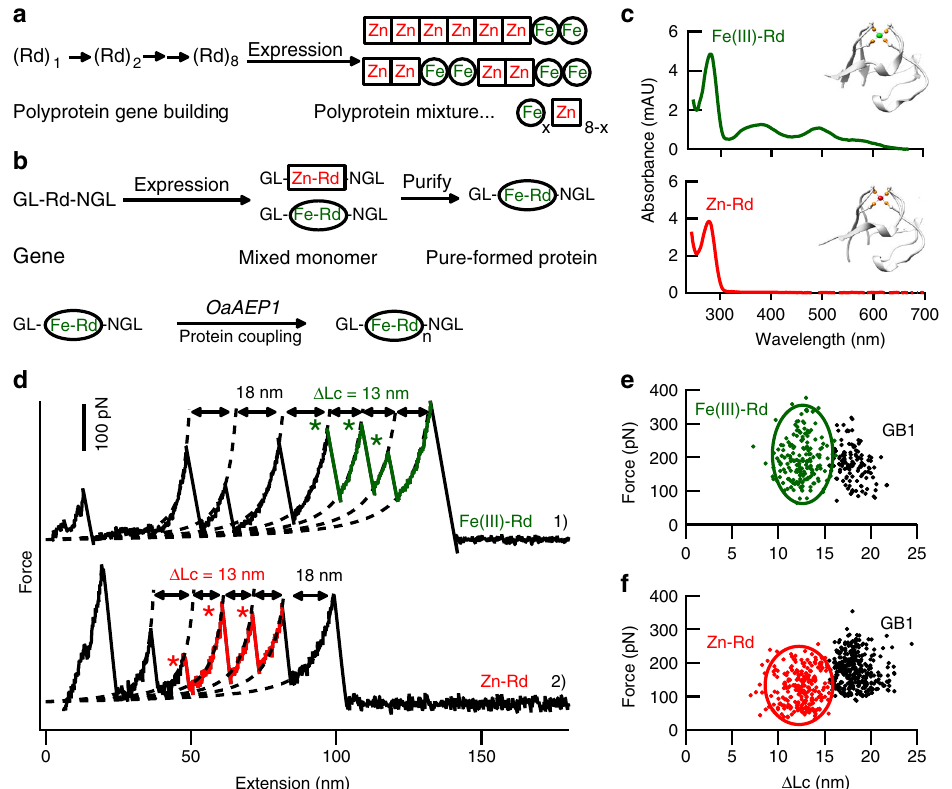
Fig. 4 The construction of polyprotein with pure metal form by OaAEP1. a The schematic shows that the recombinant DNA method-based polyprotein construction strategy results in a polyprotein (Rd) 8 with protein domains of different and uncontrolled content (metal form). b By expressing the protein as a monomer, it can be puri fi ed fi rst, and then be ligated as a pure metal-form polyprotein. c The UV-Vis absorbance spectra of puri fi ed rubredoxin monomers, GL--GB1-Fe(III)-Rd-NGL (Top spectrum, colored in green, PDB code for Fe(III)-Rd:1BRF) and GL--GB1-(Zn)-Rd-NGL (Bottom spectrum, colored in red, PDB code for Zn-Rd: 1IRN). The Fe(III)-form Rd showed a characteristic UV-Vis at the wavelength of 495 nm and 579 nm. d – f Pure metal form GL-(GB1-Rd) n -NGL, Fe( e ) and Zn( f ) built by OaAEP1 showed comparable AFM results as the bi-cysteine built polyprotein. The Δ Lc value of ~13 nm is observed as expected for rubredoxin unfolding. Source data of Fig. 4c, e and f are provided as a Source Data fi